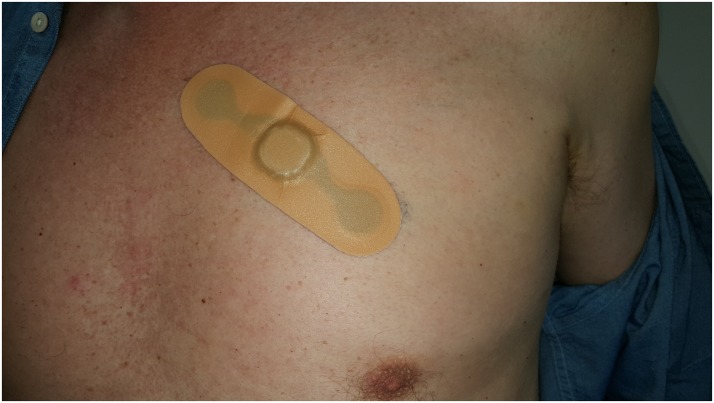
Illustration of the Health strip Cardiac Patch Monitor.